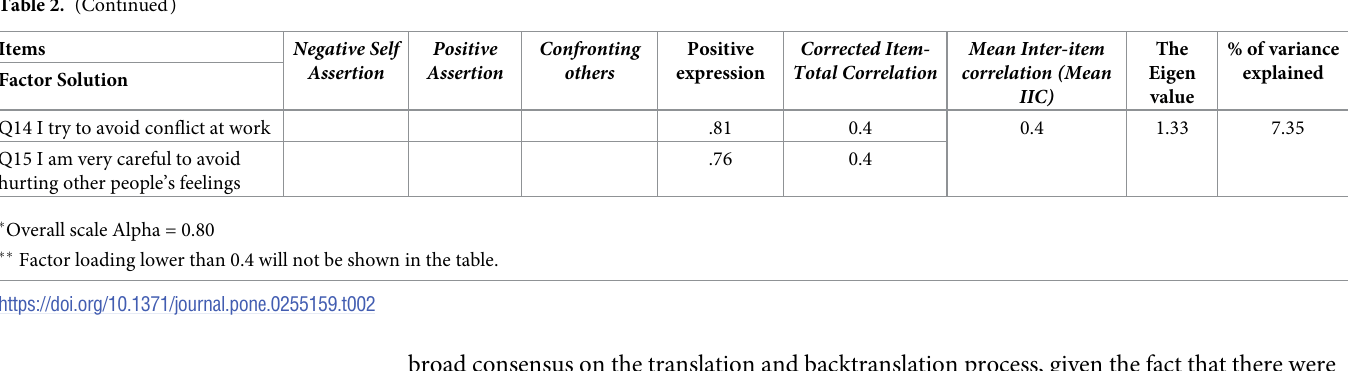
broad consensus on the translation and backtranslation process, given the fact that there were 8 raters who had to agree on the translation of all items. Upon conducting EFA and CFA, the four-factor structure was different from the six-factor structure presented in the original Irish Assertiveness Scale [7]. 8 items from the original scale